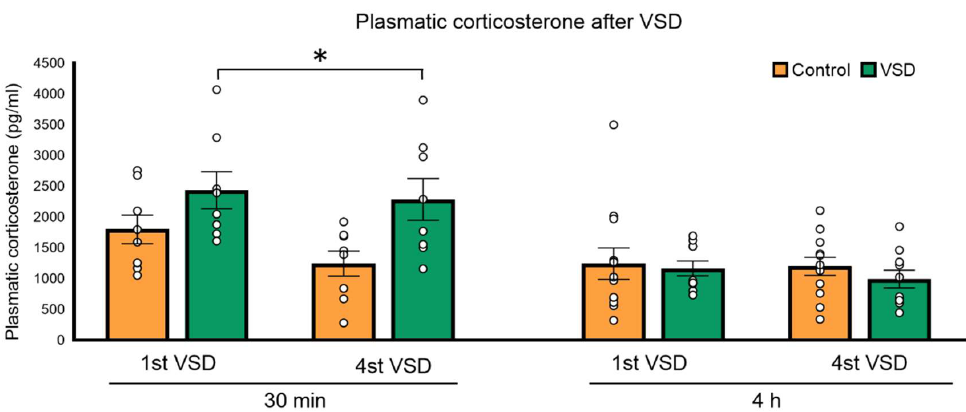
Figure 2. Vicarious Social Defeat (VSD) increased plasmatic corticosterone levels in female mice. Bars represent the mean of the plasmatic corticosterone levels (in pg/mL) 30 min (control, n = 8; VSD, n = 8) and 4 h (control, n = 8; VSD, n = 8) after the 1st and 4th social defeat (SD) in control and vicariously defeated females and the vertical lines ± SEM. Stress effect (F (1,14) = 5035; p < 0.042); * p< 0.05, significant difference compared to the control group.